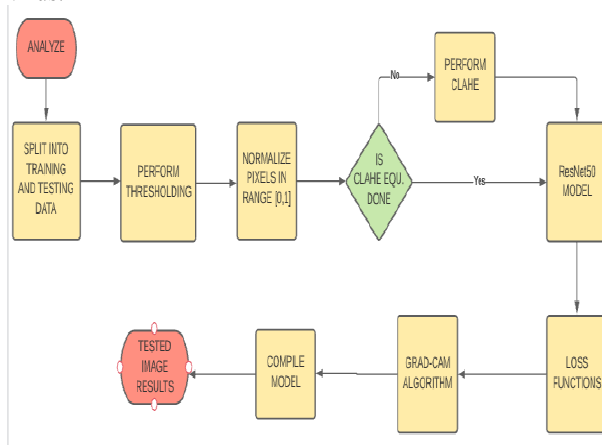
Figure 3.3: COVID-19 Detection Flow